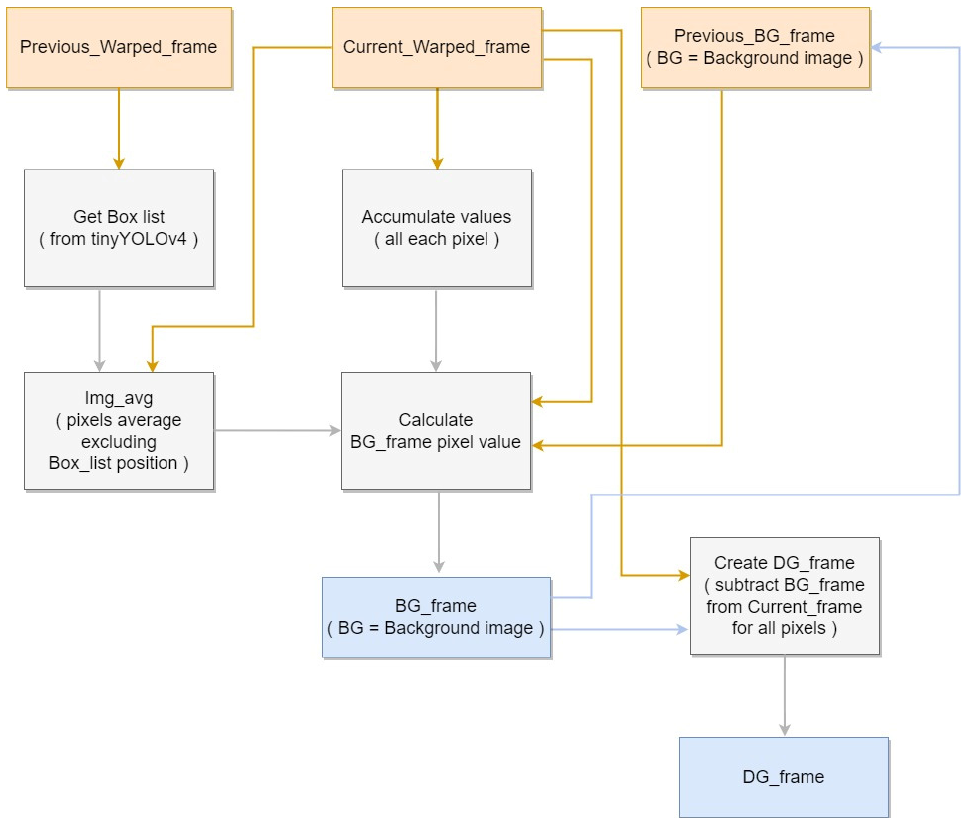
Figure 5. Background Generation block diagram.